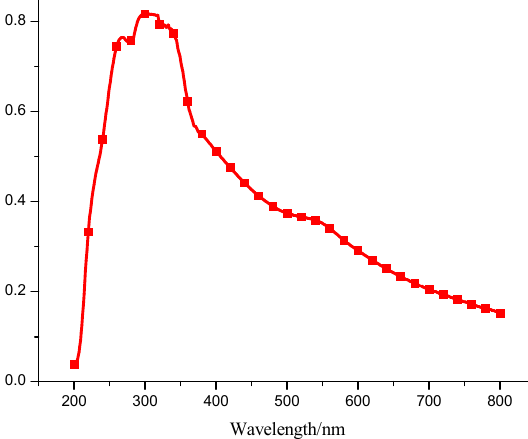
Figure 8. The solid-state diffuse reflectance UV-Vis spectra for the complex.